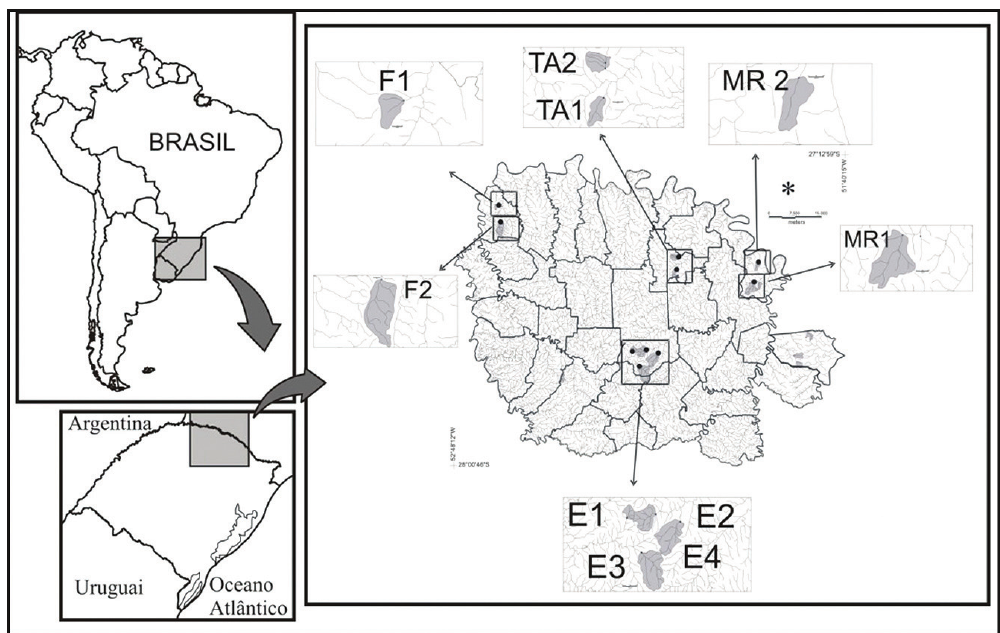
Figure 1. Location of the sampling sites in the Alto Uruguai region, F (Faxinalzinho, N=2), TA (Três Arroios, N=2), MR (Marcelino Ramos, N=2), E (Erechim, N=4), Rio Grande do Sul,